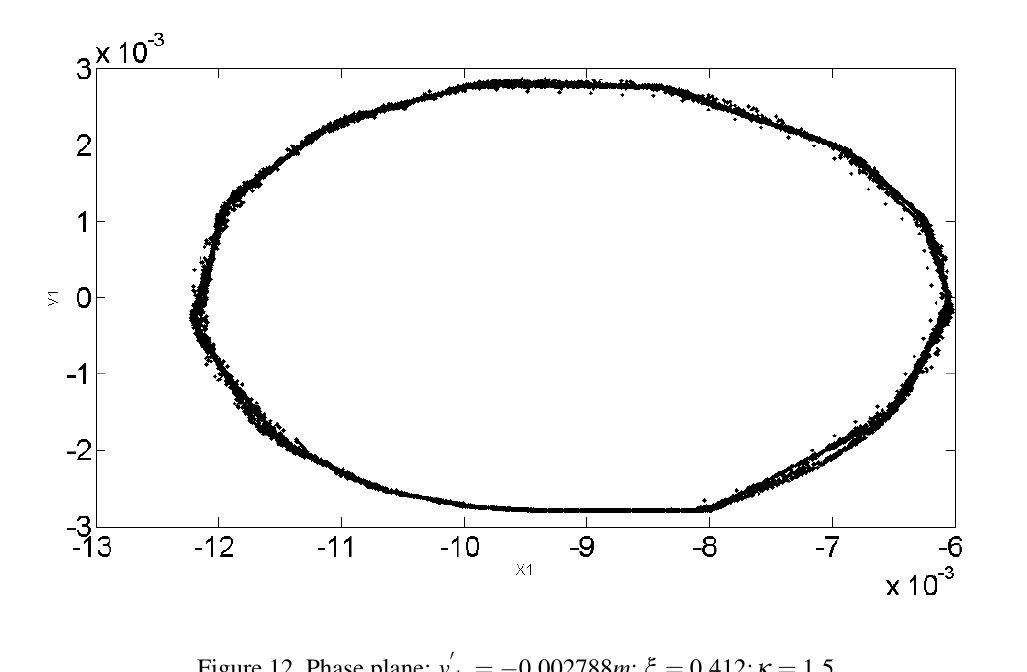
Figure 12 Phase plane: v (cid:48)